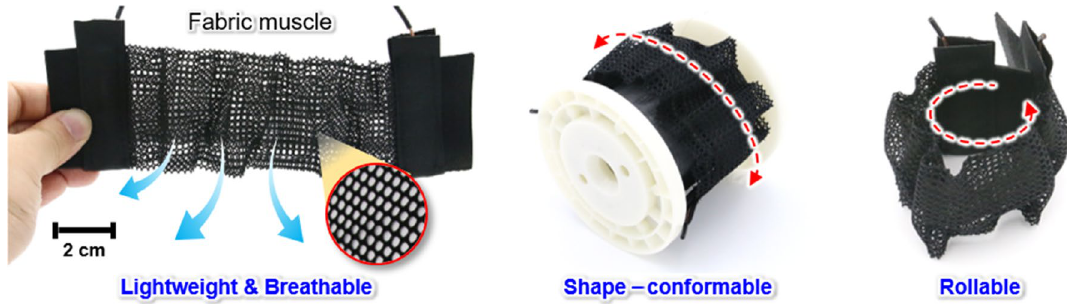
Figure 1. Breathable, light, soft, and flexible fabric muscle.